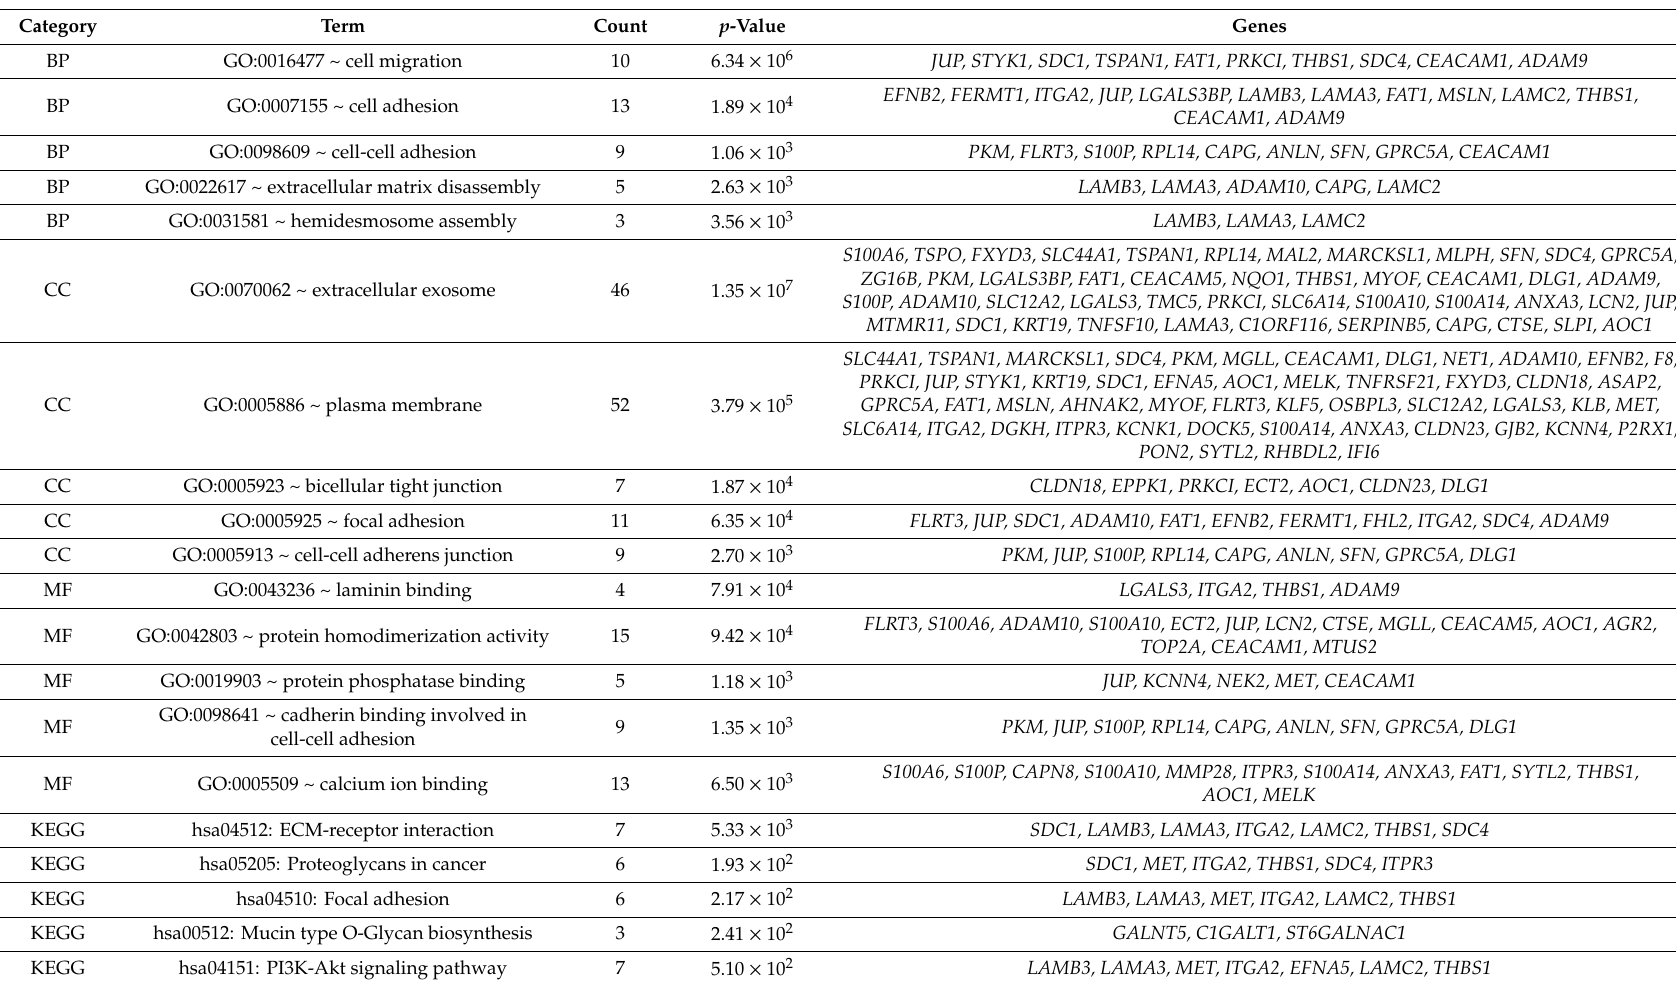
Table 1. Gene ontology and pathway enrichment analysis of di ff erentially expressed genes function in pancreatic cancer (top 5 in each